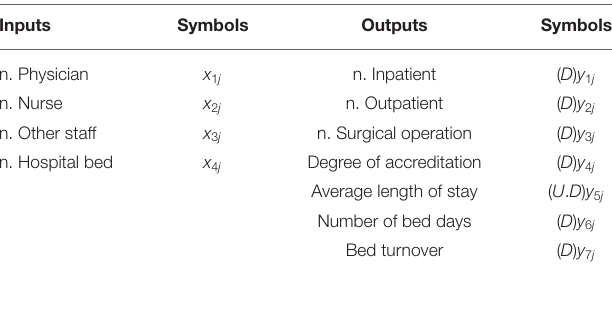
TABLE 2 | Descriptive statistics of inputs and Output variables to measure efficiency.